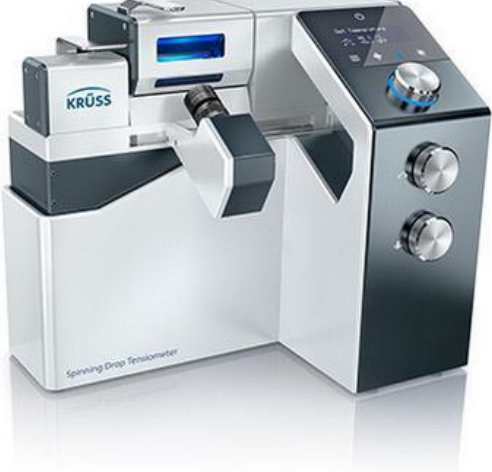
Figure 5. Spinning drop tensiometer (STD 100).